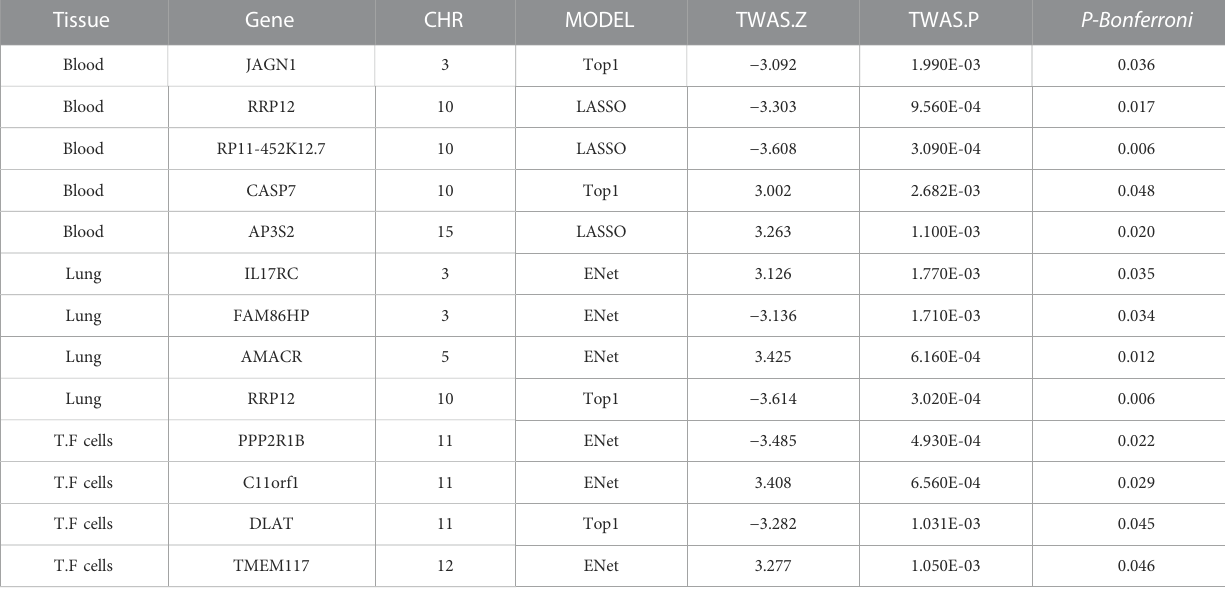
TABLE 4 Genes signi fi cantly associated with the risk of